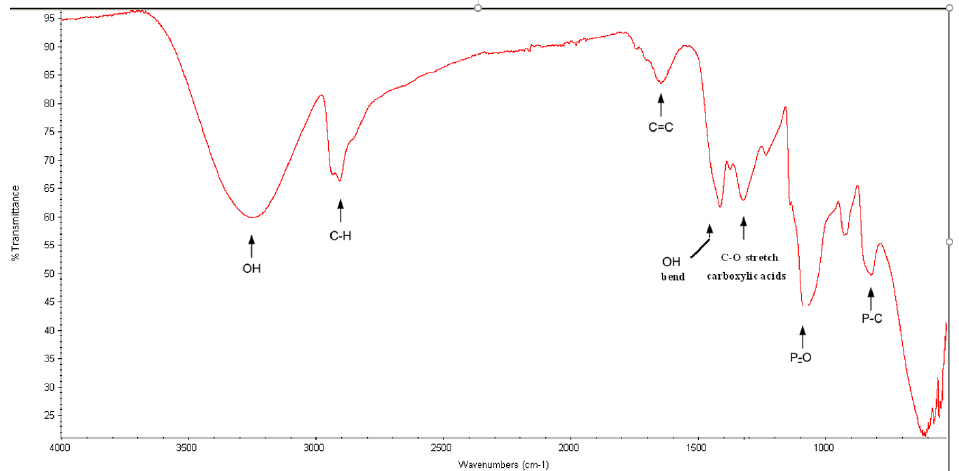
Figure 6. The IR spectrum of the membrane. Alkyl chain vibrations are observed at 2937 and 2903 cm − 1 (asymmetrical and symmetrical C-H bond valence vibrations), and 1424, (caused by coupling of the O-H scissoring with the C-H wagging in the -CH-OH groups of PVA [29]). The very weak band at 1743 cm − 1 is probably due to the stretching of C=O bonds from acetate groups remaining in PVA (incomplete hydrolysis of the polyvinyl acetate during PVA synthesis). The bands at 1382 and 1326 cm − 1 can be attributed to stretching vibrations of C-N bonds in aminophosphonic acids [30] and free P=O bonds [7,31], respectively. The band at 1082 cm − 1 is assigned to the ν as (P-O) stretching modes of the central PO 4 tetrahedron in [PW 9 O 34 ] 9 − anion [25]. The shoulder at ∼ 1000 cm − 1 is referred to ν as (P-O) stretching mode in a